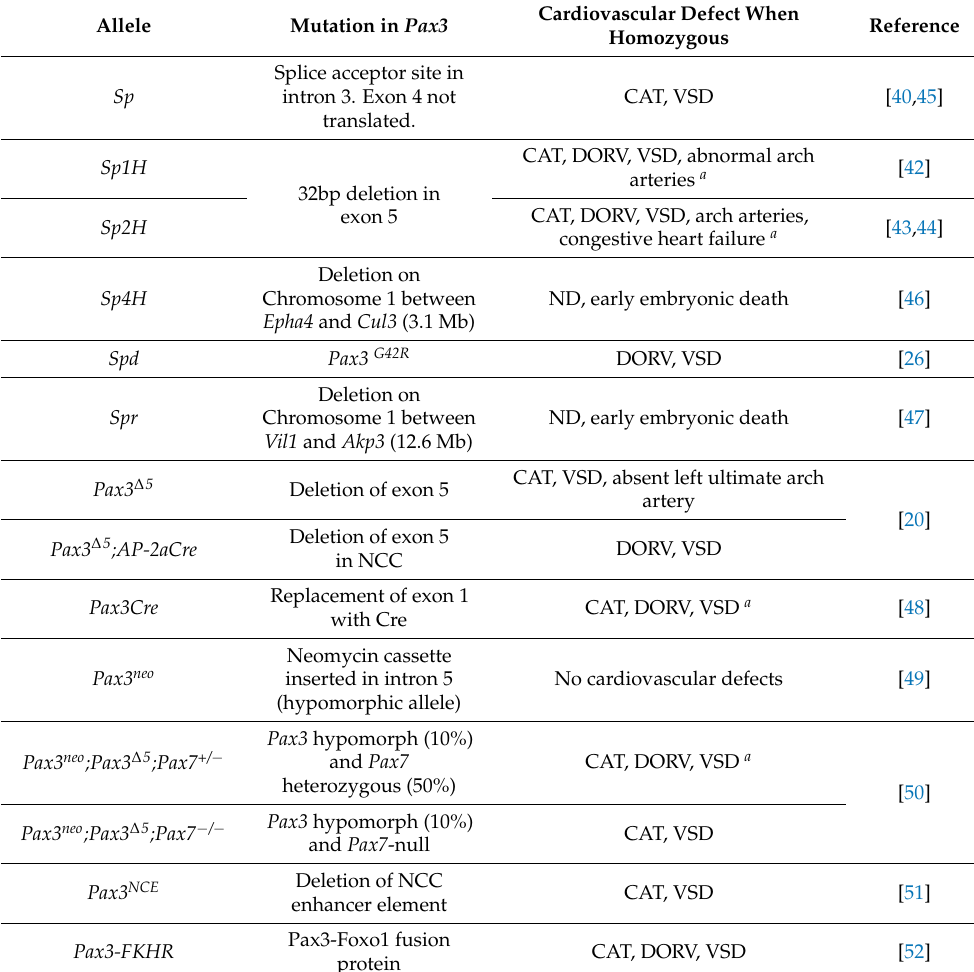
Reference [42] [43,44]